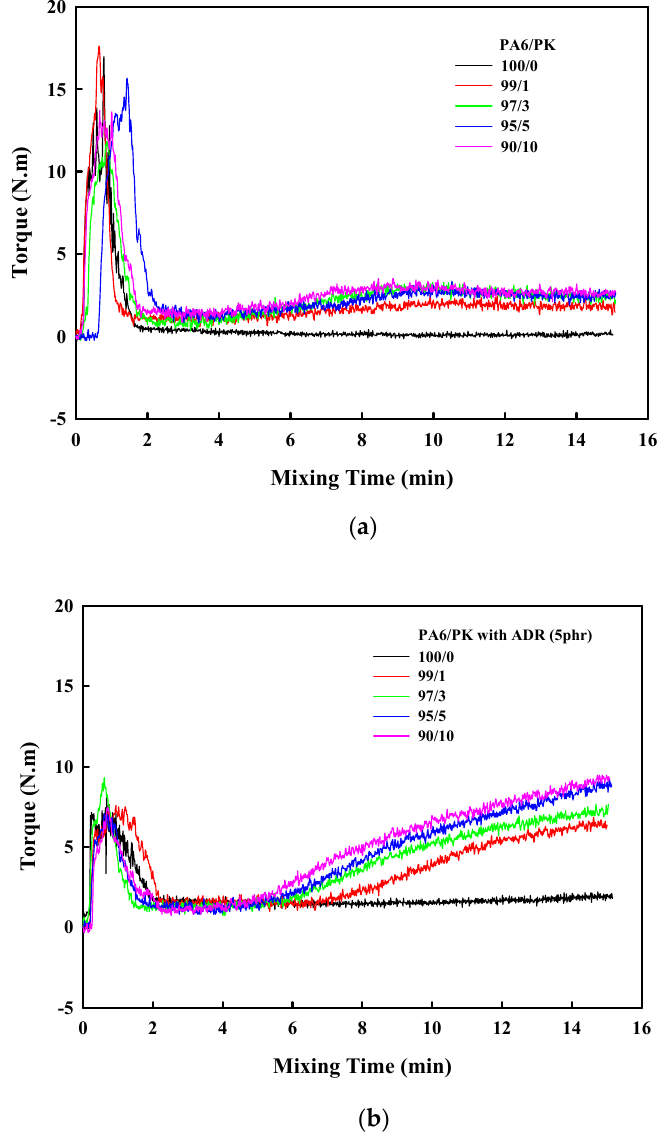
Figure 1. Melt torque as a function of mixing time for PA6/PK blends; ( a ) without chain extender; ( b ) with chain extender(5phr).